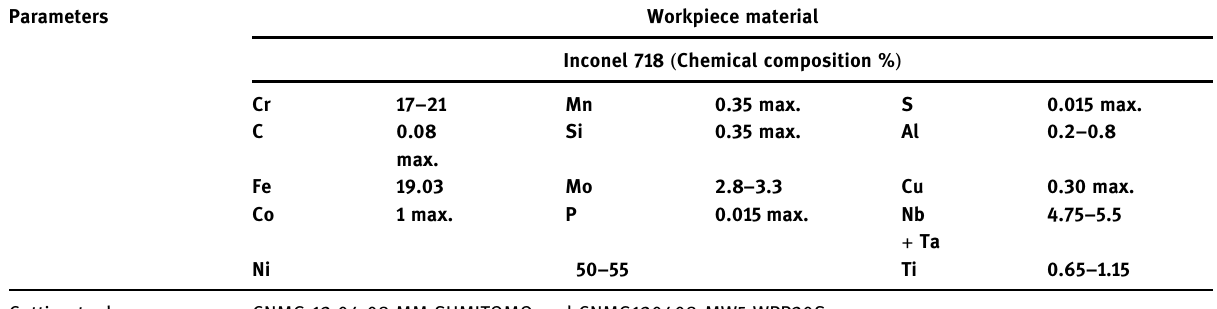
Table 1: Machining input process parameters Parameters Workpiece